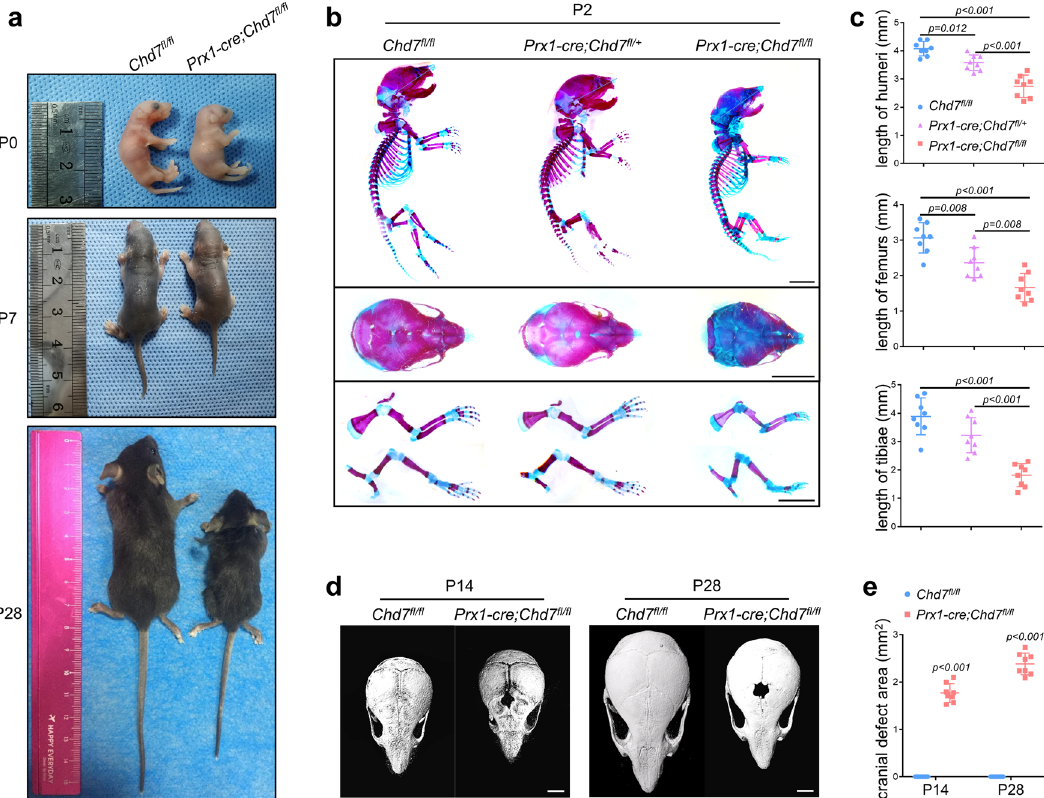
Fig. 1 Deletion of Chd7 in MSCs leads to skeletal development disorder. a Representative images of the Chd7 fl / fl and Prx1-cre;Chd7 fl / fl mice at postnatal day 0, day 7, and day 28. b Alizarin red/Alcian blue whole-mount skeletal staining images of the Chd7 fl / fl , Prx1-cre;Chd7 fl / + , and Prx1-cre;Chd7 fl / fl pups at postnatal day 2. Compared to the control littermates, The Prx1-cre;Chd7 fl / fl pups had shorter forelimbs and hindlimbs and a lower degree of mineralization in the cranial and maxillofacial bone. Scale bar, 5 mm. c Quanti fi cation of ( b ), including the length of humeri, femurs, and tibiae of the mice at postnatal day 2 ( n = 8). d Representative reconstructed microCT images of skulls of the 2-week-old and 4-week-old Chd7 fl / fl and Prx1-cre;Chd7 fl / fl mice. The skulls of Prx1-cre;Chd7 fl / fl mice showed nonclosure of fontanels. Scale bar, 2 mm. e Quanti fi cation of ( d ), cranial defect area calculated by ImageJ ( n = 8). Data are shown as the mean ± S.D.; p value by two-tailed for independent sample tests or one-way ANOVA with Tukey ’ s post hoc tests for multiple